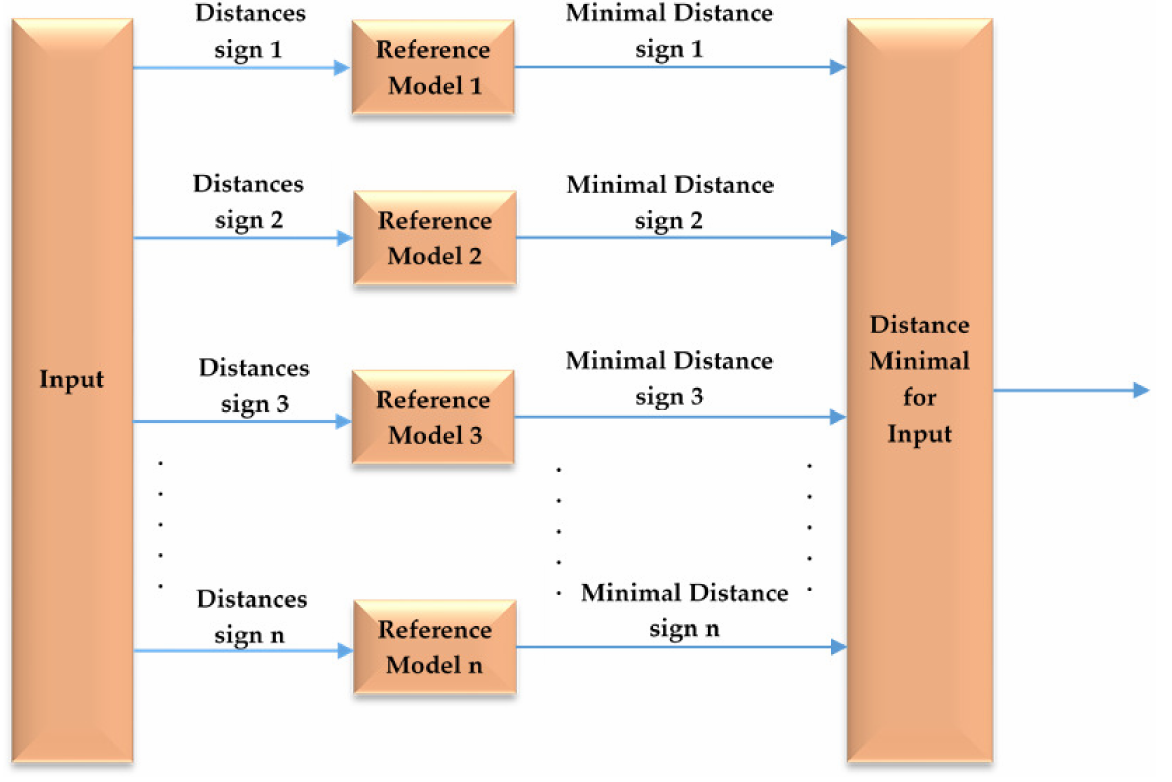
Figure 9. Comparator